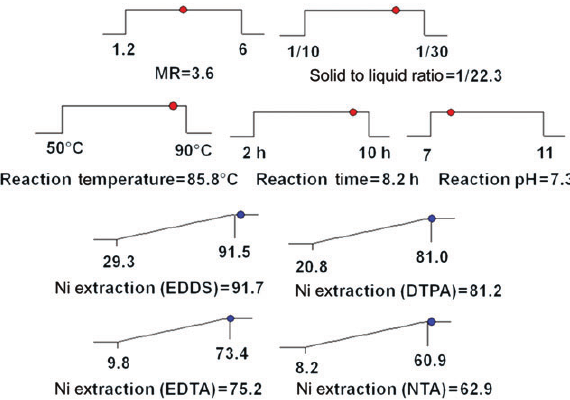
Figure 6 Ramps of the numerical